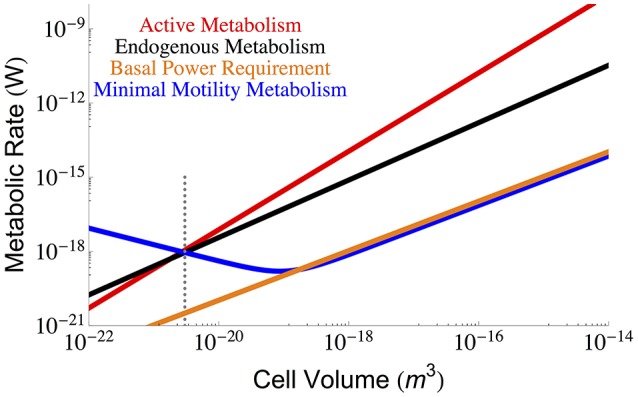
The overall scaling of total (red) and maintenance (black) metabolism along with predictions for the minimal energy required for cellular motility assuming run-tumble chemotaxis (Berg and Turner, 1990; Mitchell, 2002). The dotted gray line indicates the smallest known bacterial cells (Luef et al., 2015; Kempes et al., 2016).